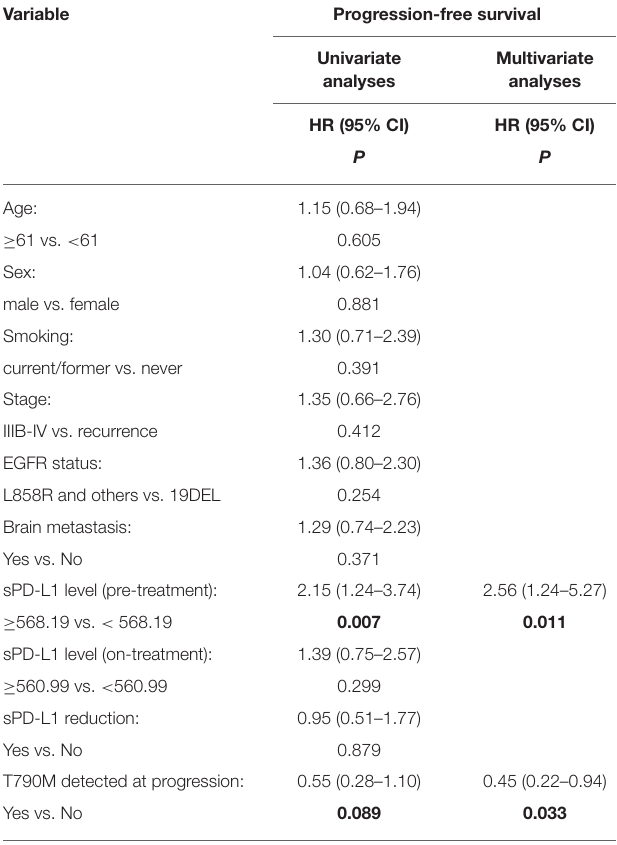
TABLE 4 | Univariate and multivariate analysis of the clinical factors associated with progression-free survival. Variable Progression-free survival